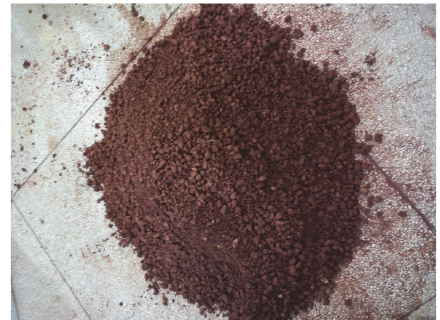
Figure 3: The crushed red-bed soft rock mixtures.